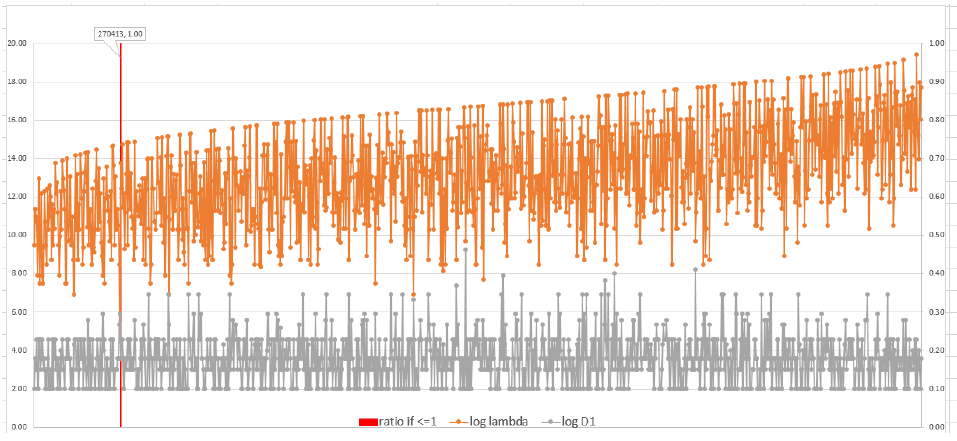
Figure 5. p 1 = 11, m = 4, p m ≤